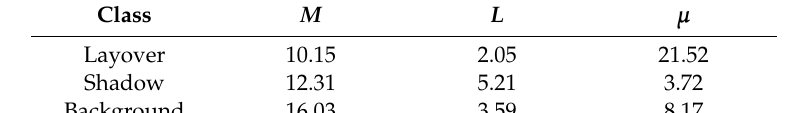
Table 1. Estimations of Fisher distribution.